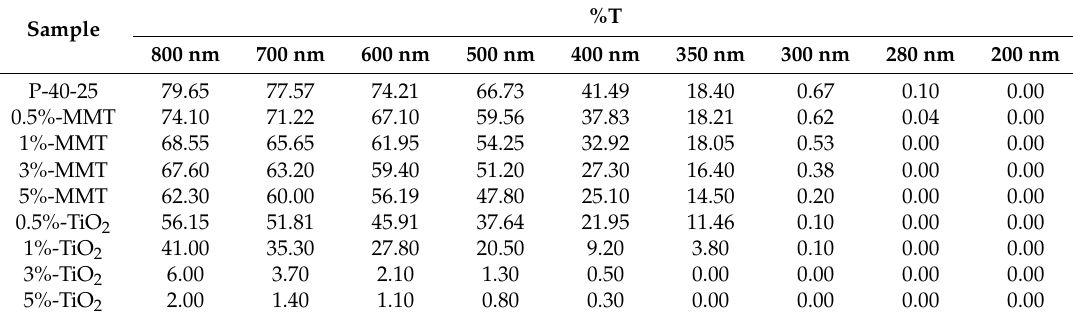
Table 3. Transmittance of the FK/PVA/Tris blend films modified with different contents of MMT and TiO 2 .